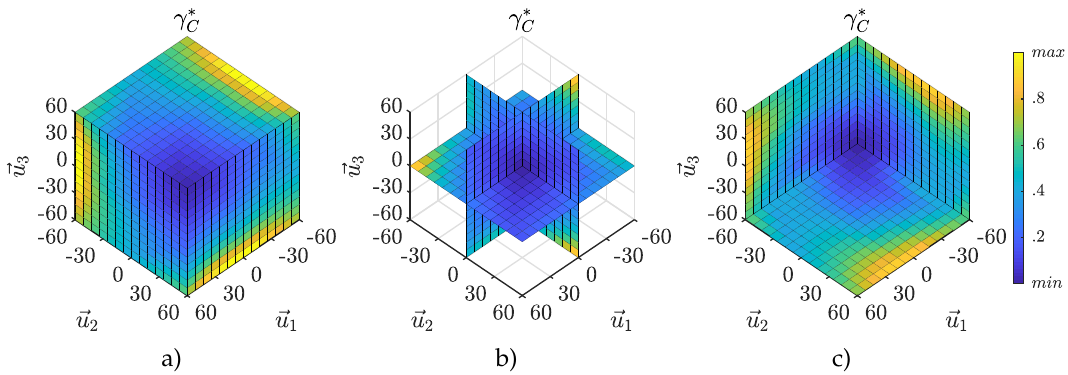
Figure 5. Isotropy distribution: ( a ) Outer surfaces, ( b ) middle surfaces, ( c ) inner surfaces.